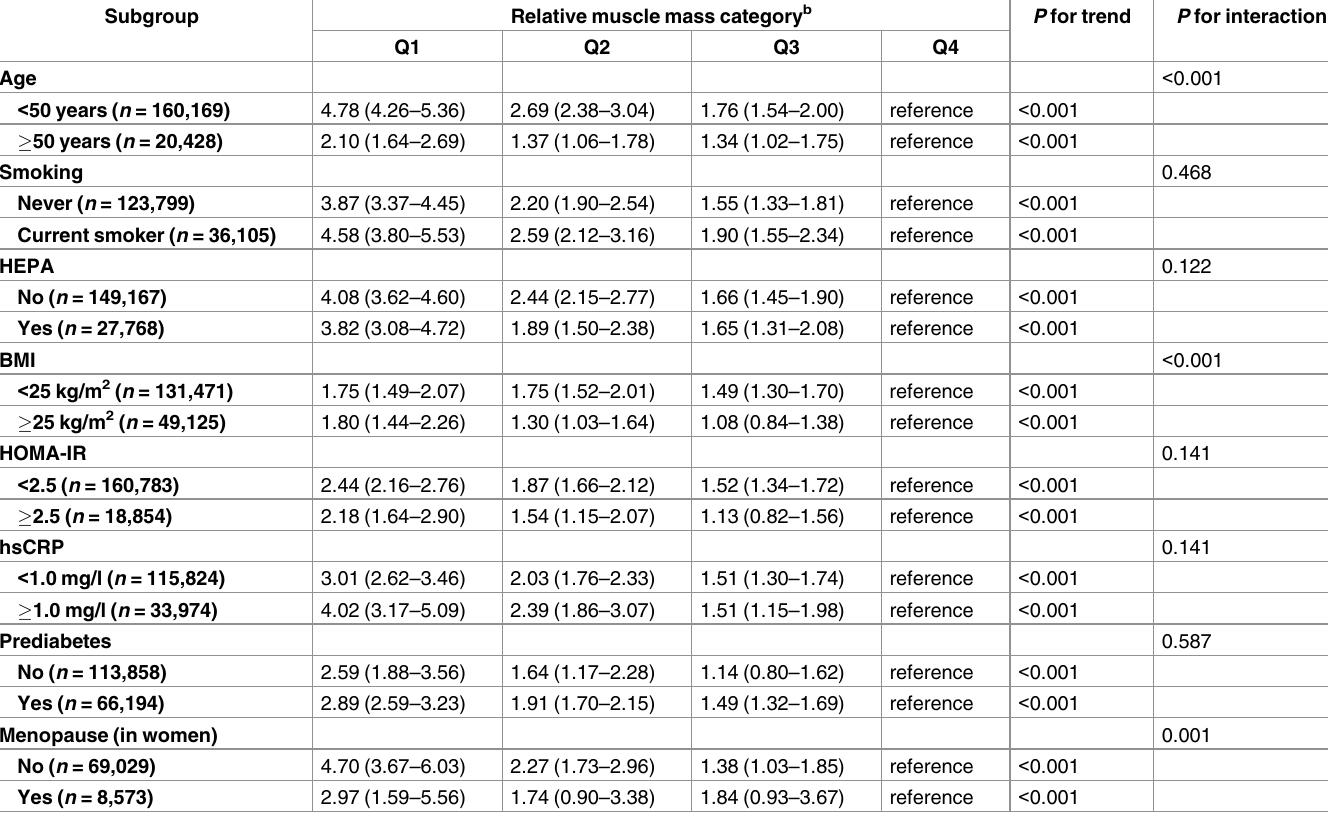
Table 4. Hazard ratios a (95% CI) of incident diabetes according to relative muscle mass category in clinically relevant subgroups. Subgroup